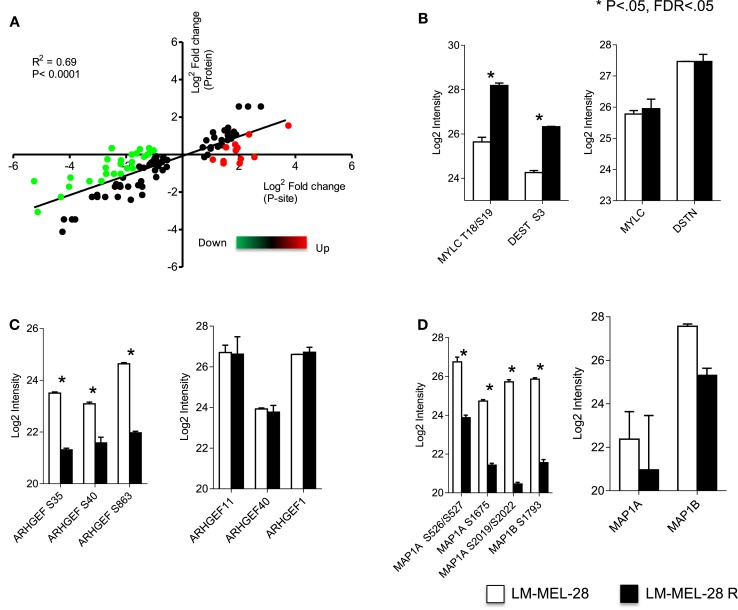
Phosphorylation rate analysis. (A) Correlation of metrics for P-site effect with protein abundance effect measured between drug sensitive and resistant cell populations. Green = P-site effect twofold > protein effect. Red = P-site effect twofold < protein effect. Log2 intensity of P-sites and total protein for key cytoskeletal regulators (B) myosin and destrin, (C) guanidine exchange factors (11, 40, and 1), and (D) microtubule-associated proteins 1A and 1B analyzed using a Student’s t-test (error bars are SD).